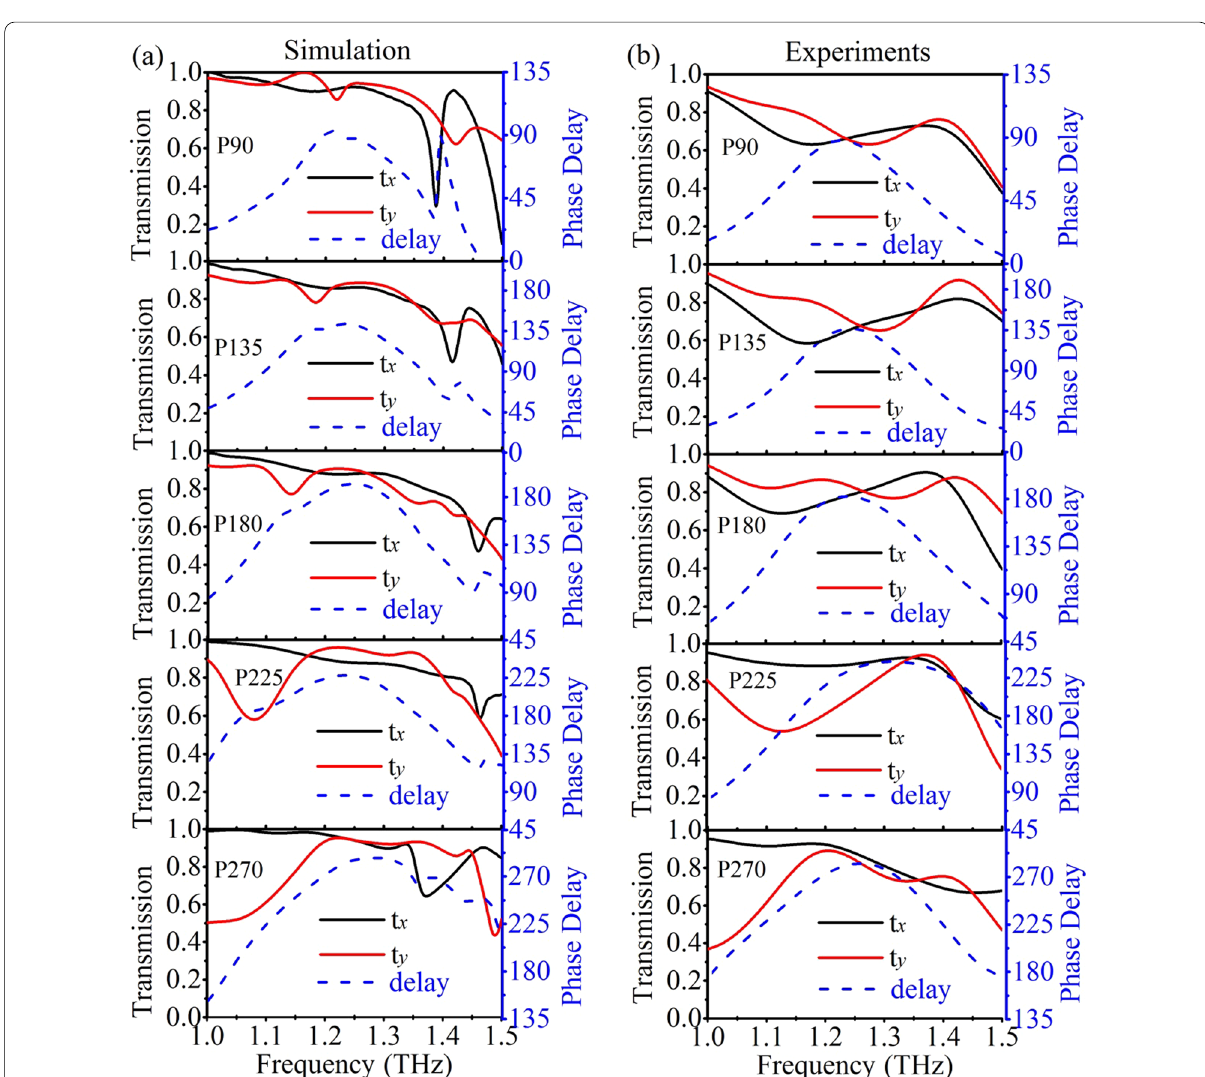
Fig. 2 a Simulated and b experimental measured transmission coefficients and phase delays of the dielectric metasurfaces for the designs of P90, P135, P180, P225 and P270,